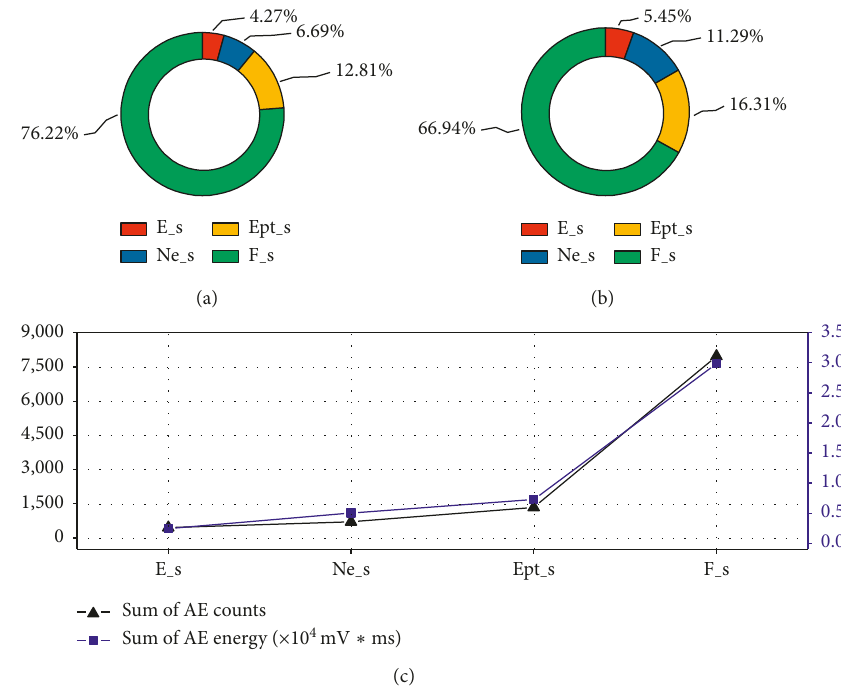
Figure 16: Trends in AE event counts and energy counts of layered concrete blocks and their respective percentages (legends as per Figure